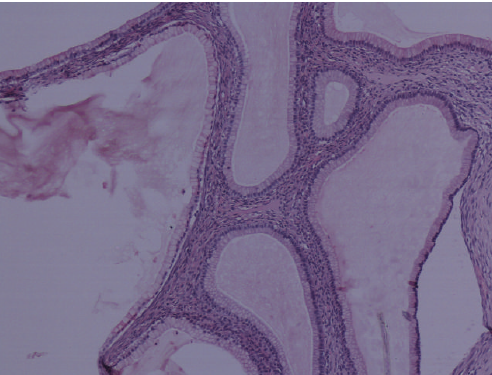
Figure 3: Metastatic renal cell carcinoma in the ovary, forming nests of clear cells separated by thin fibrovascular stroma.